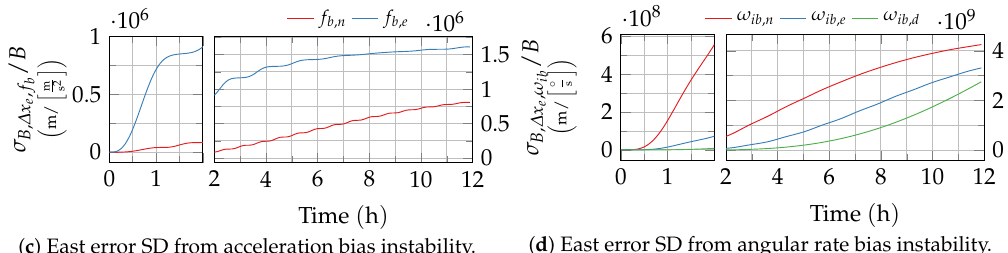
( c ) East error SD from acceleration bias instability. ( d ) East error SD from angular rate bias instability. Figure 8. Position error growth from bias instability with T 0 = 5000s. The time axis of the plots is split to provide a better resolution of the short-term response.